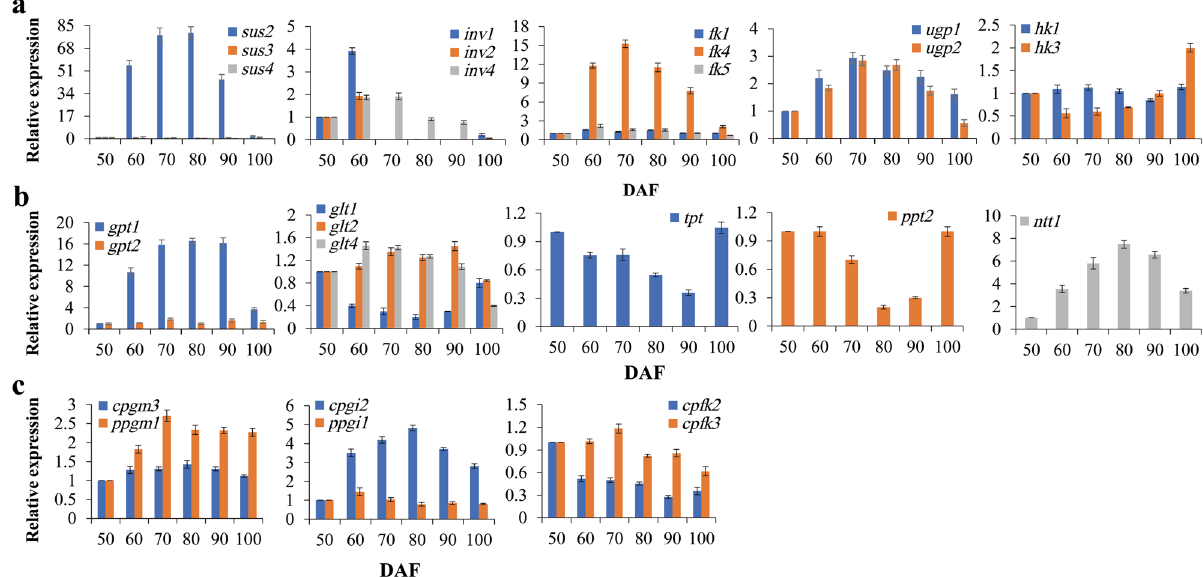
Figure 5. Transcriptional expression analysis of genes encoding enzymes involved in sucrose cleavage and carbon allocation in developing CCSK via qRT-PCR. Error bars display SD, n = 3. ( a ) Differential transcription patterns of enzymes related to sucrose cleavage determined via qRT-PCR. ( b ) Differential transcription patterns of transporters related to carbon allocation determined via qRT-PCR. ( c ) Differential transcription patterns of enzymes related to carbon allocation determined via qRT-PCR. cpgm3 , cytosolic pgm3 ; ppgm1 , plastidial pgm1 ; cpgi2 , cytosolic pgi2 ; ppgi1 , plastidial pgi1 ; cpfk , cytosolic pfk